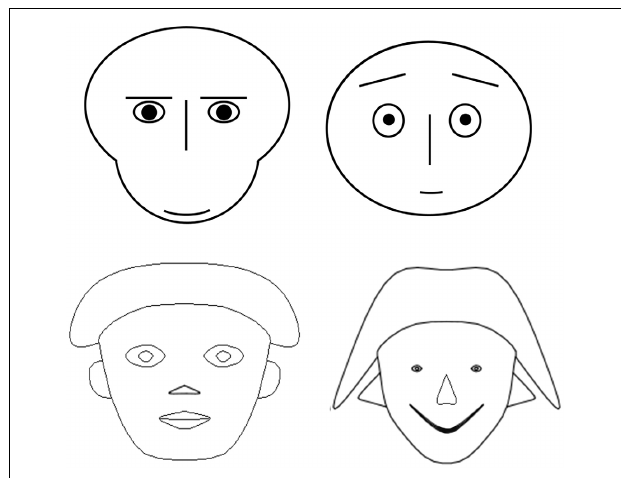
FIGURE 4 | Examples of Chernoff style